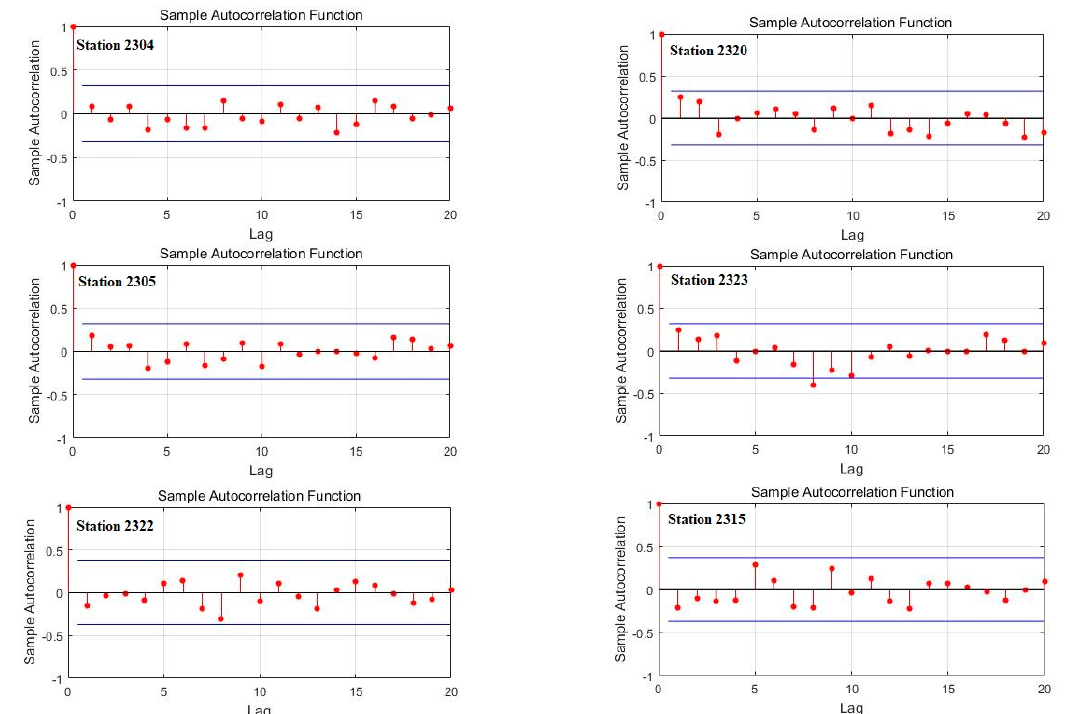
Figure 4. Autocorrelation plots of the 7-day low-flow series.